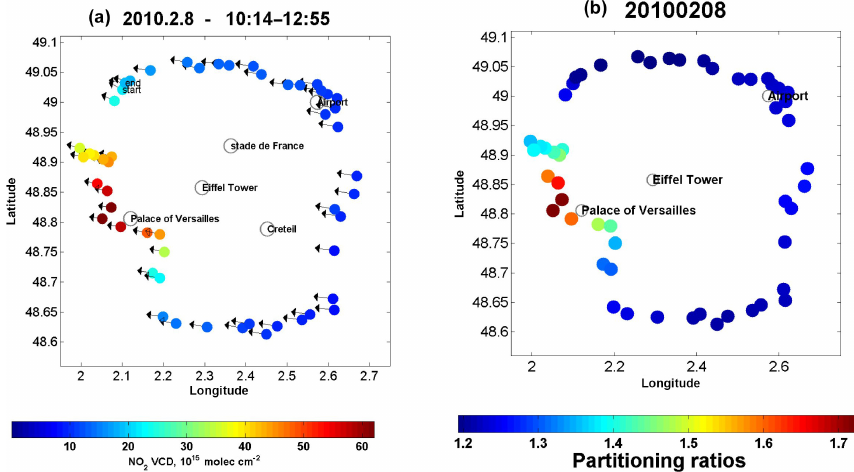
Figure 5. (a) NO 2 VCDs retrieved from car MAX-DOAS measurements on 8 February 2010. (b) Partitioning ratios (NO x / NO 2 ) derived from model simulations at the locations of the car MAX-DOAS observations. High partitioning ratios are found at the same locations of the maximum NO 2 VCDs.